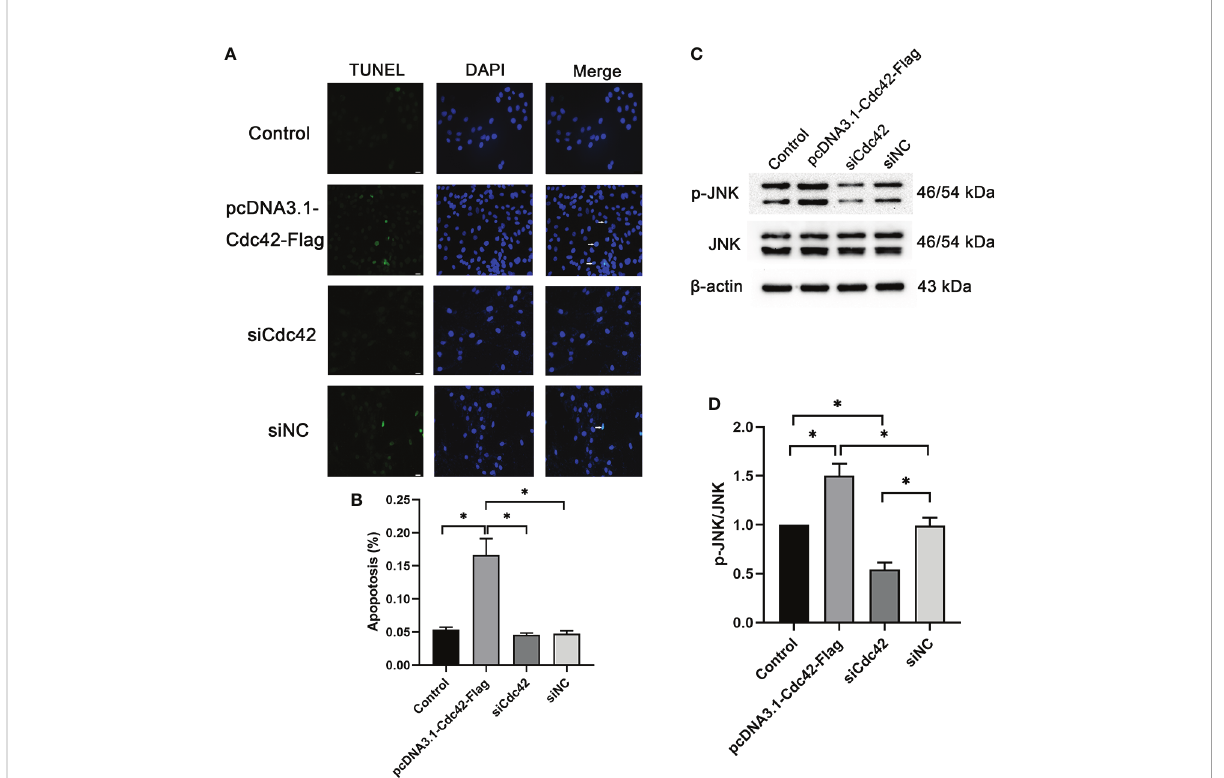
FIGURE 4 Upregulation of Cdc42-induced podocyte apoptosis. (A) The control podocytes, podocytes transfected with the plasmid carrying the Cdc42 gene, podocytes transfected with Cdc42 - siRNA, and podocytes transfected with negative control siRNA were cultured in a medium containing glucose (5.5 mM). White arrows point to TUNEL-positive podocytes (apoptotic podocytes); magni fi cation: ×200; scale bar = 25 m m. (B) The apoptosis rate (%) was calculated by dividing the number of TUNEL-positive cells by a population of 100 counted cells per condition. The podocyte apoptosis rate increased signi fi cantly after Cdc42 upregulation. The data were from at least three independent experiments. (C, D) The protein expression levels of JNK and p-JNK were detected. When transfected with the plasmid carrying the Cdc42 gene, the p-JNK/ JNK ratio decreased signi fi cantly compared to the negative control, whereas transfection with Cdc42-siRNA increased the p-JNK/JNK ratio. The data are means ± SEM; * P <